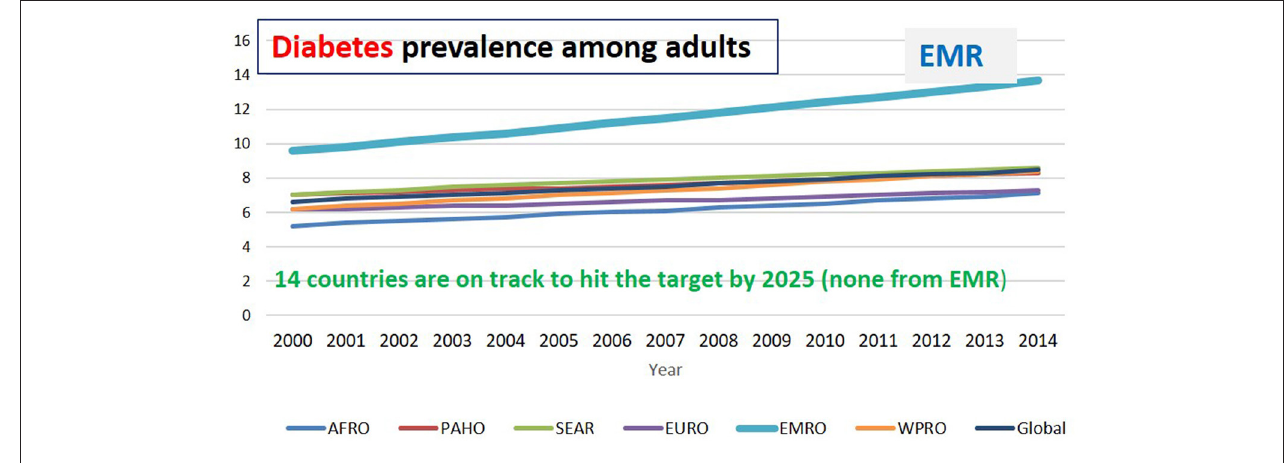
FIGURE 2 | Diabetes prevalence among adults in different regions